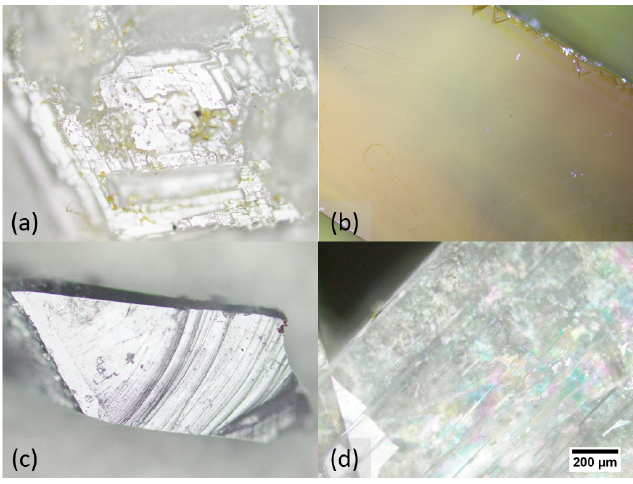
Figure 3. Optical images of: ( a ) Hexamine ( b ) IAA ( c ) Melamine ( d )